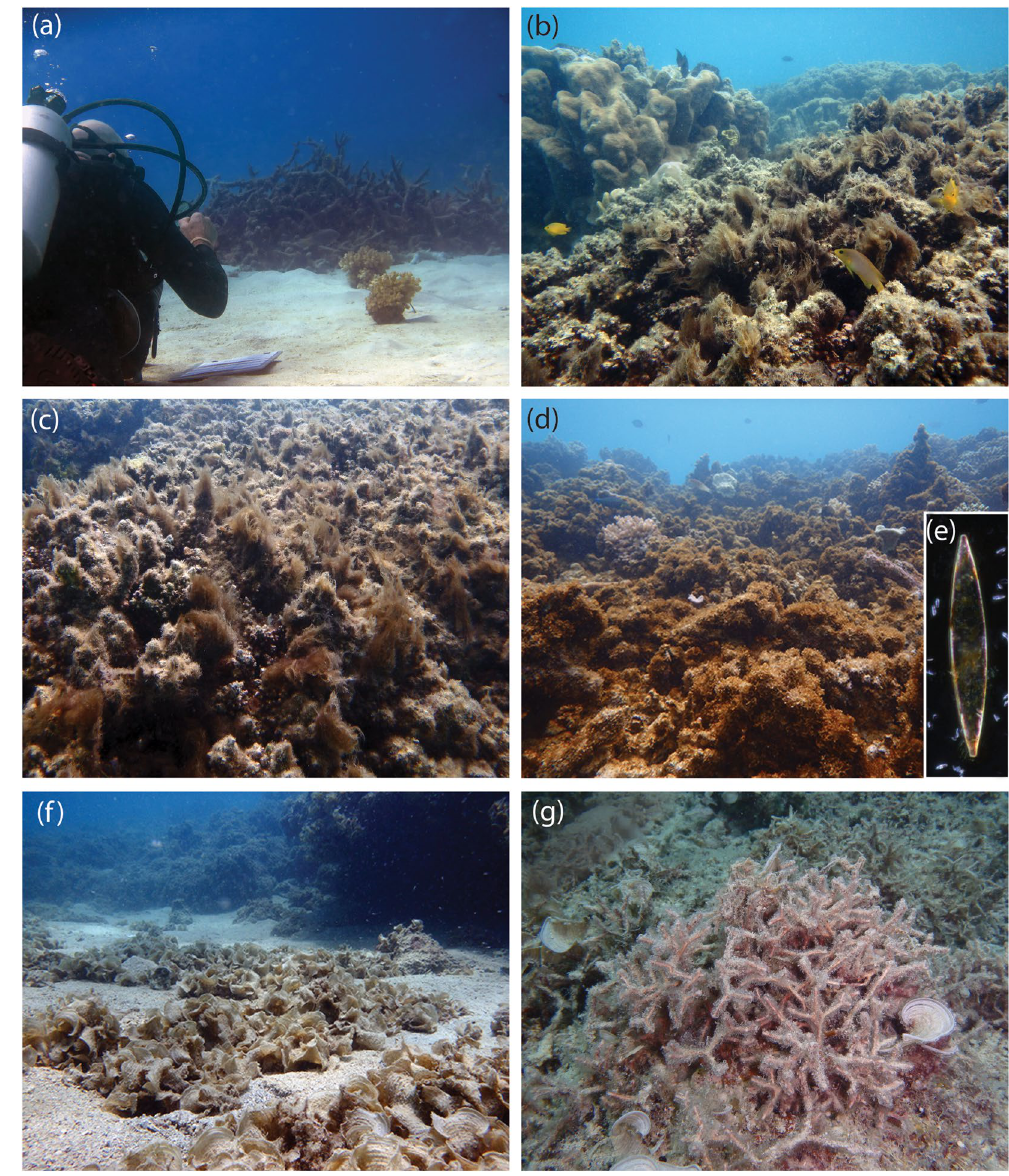
Figure 1. Habitat types under study. ( a ) Patches of live healthy Pocillopora damicornis on a shallow sand flat in front of a large bed of dead-degraded coral, with a diver observing the behaviour of a juvenile fish with the aid of a magnifying glass. ( b ) Degraded reef with a mixture of algal/bacterial species. ( c ) An area of dead coral covered with Okeania sp. cyanobacteria. ( d ) An area of dead coral covered with turfing algae covered with a diatom bloom of Pseudo-nitzschia sp. ( e ) The diatom, Pseudo-nitzschia sp.isolated from the bloom. ( f ) A sand gutter filled with the brown algae, Padina sp. ( g ) The red algae, Galaxaura rugosa , (surrounded by some Padina sp.). Photograph credits M.